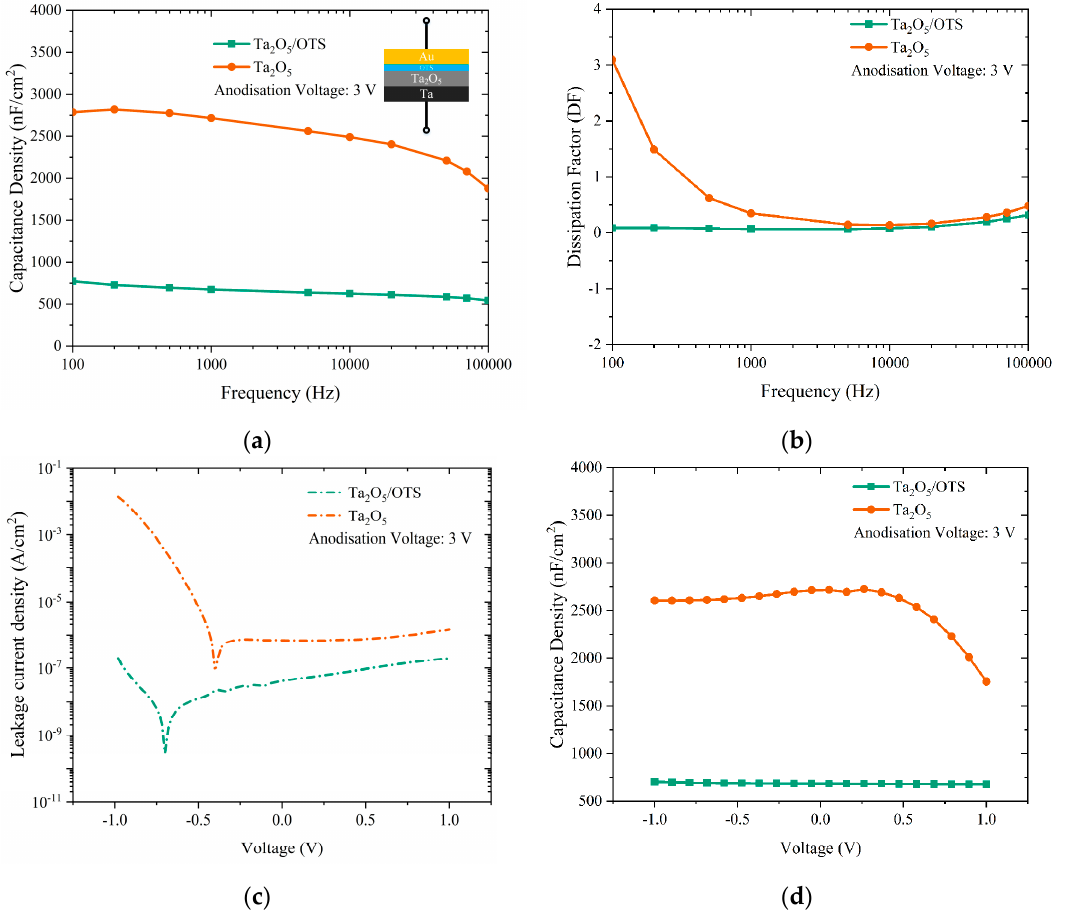
Figure 5. ( a ) Capacitance density and ( b ) dissipation factor vs. frequency, as well as ( c ) leakage current density and ( d ) capacitance density vs. voltage characteristics of the 3 V anodized Ta/Ta 2 O 5 /Au capacitors with and without OTS treatment.